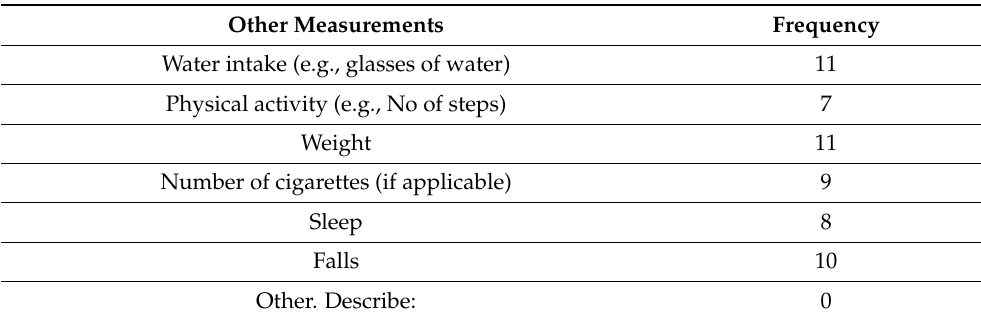
Table 11. Additional measurements that would be of interest to the healthcare professionals (select multiple options allowed).